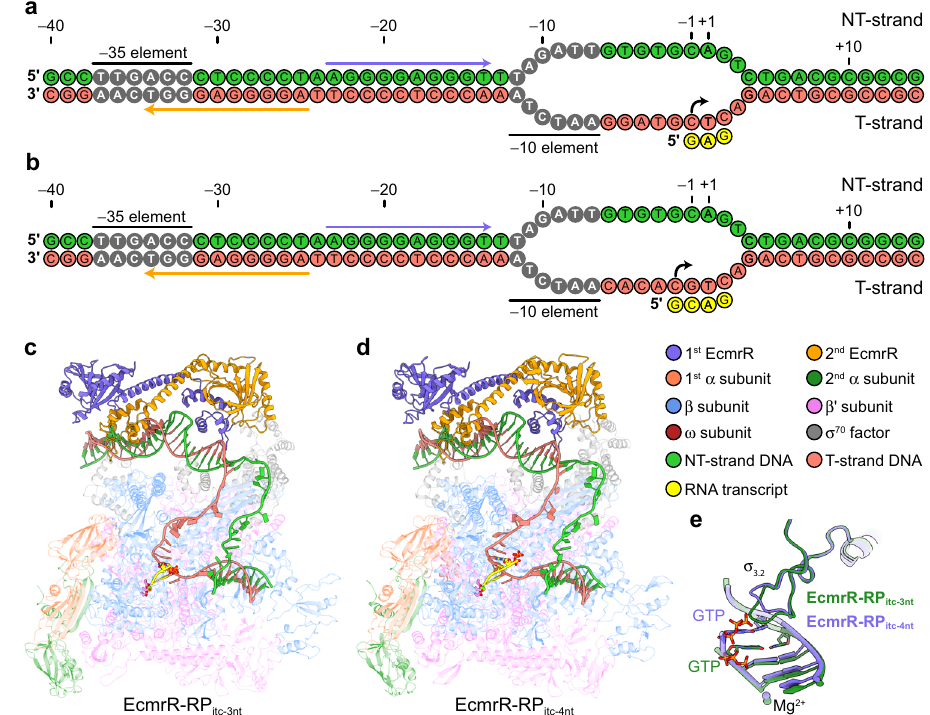
Fig. 3 Structures of EcmrR-RNAP-promoter initial transcribing complexes. a Schematics of synthetic promoter DNA scaffolds and de novo synthesized RNA transcripts in EcmrR-RP itc-3nt. The two halves of the palindromic sequence recognized by EcmrR dimer are highlighted by medium blue and orange arrows, respectively. The transcription start site is indicated by a curved arrow. NT-strand, non-template strand; T-strand, template strand. b Schematics of synthetic promoter DNA scaffolds and de novo synthesized RNA transcripts in EcmrR-RP itc-4nt . c Overall cryo-EM structure of EcmrR-RP itc-3nt . The 5 ′ -end GTP in the nascent RNA transcript and three catalytic aspartate residues ( β ' D460, β ' D462 and β ' D464) in the polymerase active center are shown as sticks. The Mg 2 + ions are shown as green spheres. d Overall cryo-EM structure of EcmrR-RP itc-4nt . e Superimposition of RNA-DNA hybrid duplex and σ 3.2 loop in EcmrR-RP itc-3nt (forest green) and EcmrR-RP itc-4nt (medium blue) illustrates the slight uplift of σ 3.2 loop to avoid steric clashes when the length of RNA transcript reaches 4